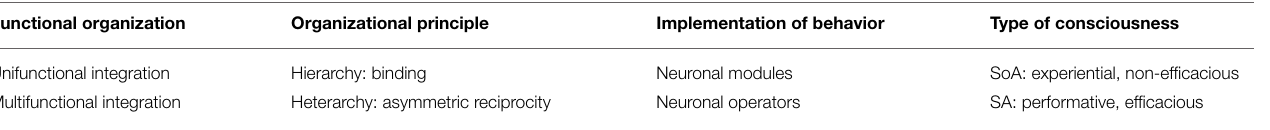
TABLE 1 | Functional organization of unifunctional (SoA) and multifunctional (SA) integration. Functional